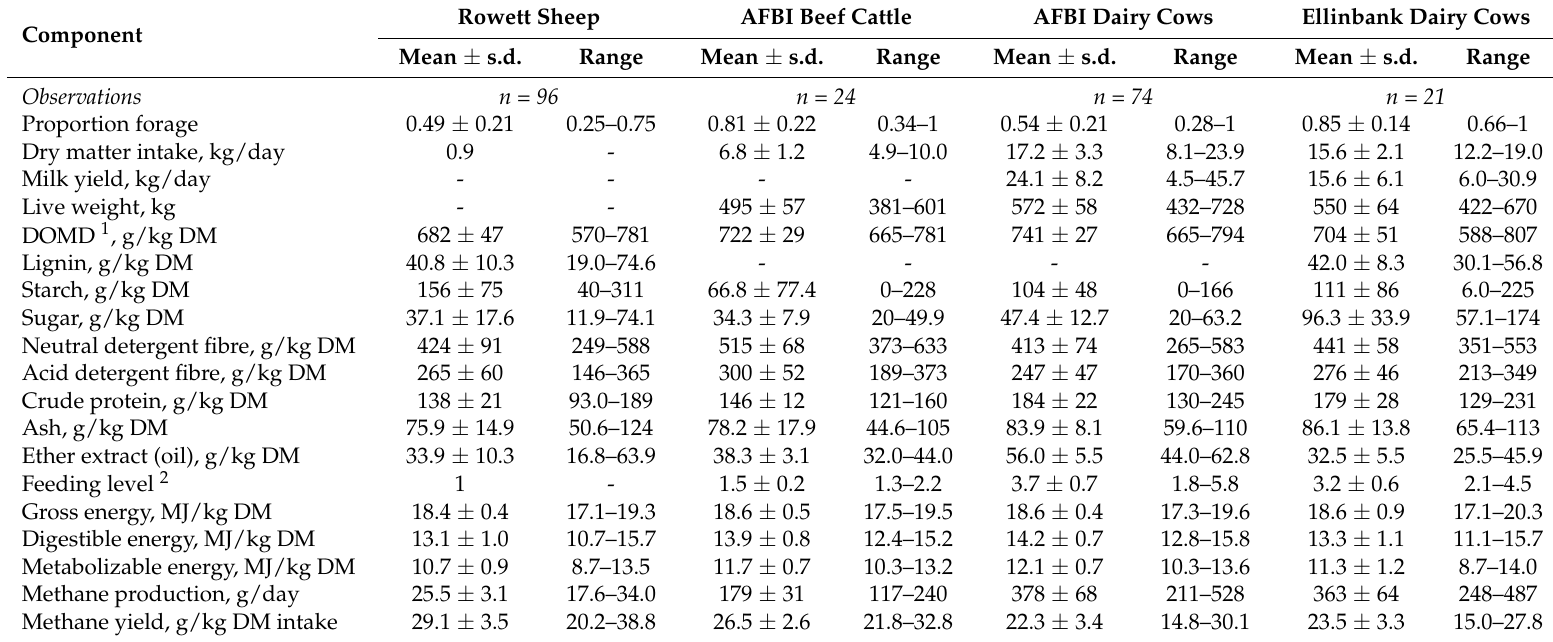
Table 2. Average production values and composition of diets fed to sheep at the Rowett Institute [13], beef cattle and dairy cows at AFBI and dairy cows at Ellinbank Research Centre for data used to evaluate CH 4 prediction